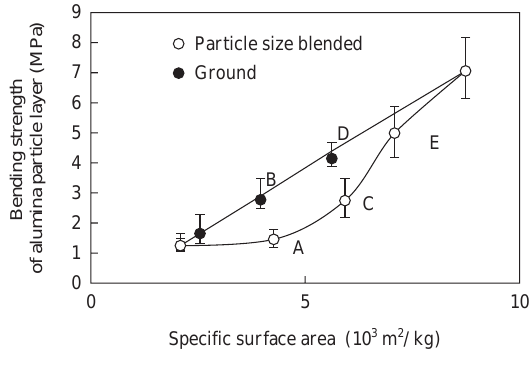
Fig. 12 Bending strength of alumina particle layer after heat treatment at 827K as a function of specific surface area for particle size blended powder